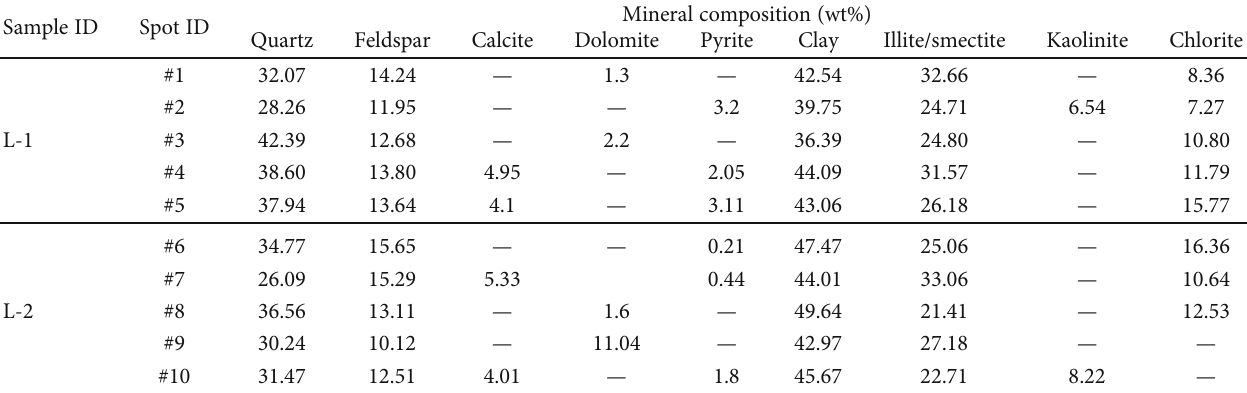
Table 3: Mineral composition calculated from micro-FTIR spectra of the Yanchang shale samples. Sample